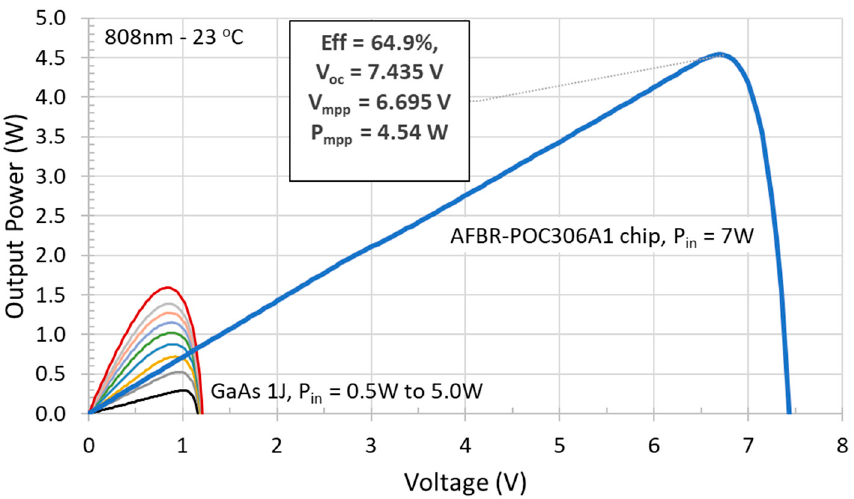
Figure 2. Power–voltage results of Broadcom’s medium-power PT6 chips measured at an optical input power of P in = 7 W at 808 nm (blue curve). The chip area is 0.14 cm 2 , giving an average optical intensity of 48 W/cm 2 at 7 W. The multiple curves near 1 V are obtained with a single junction GaAs OPC measured with an optical input power between 0.5 W (black curve with Eff = 58.8%) and 5.0 W (red curve with Eff = 31.8%).